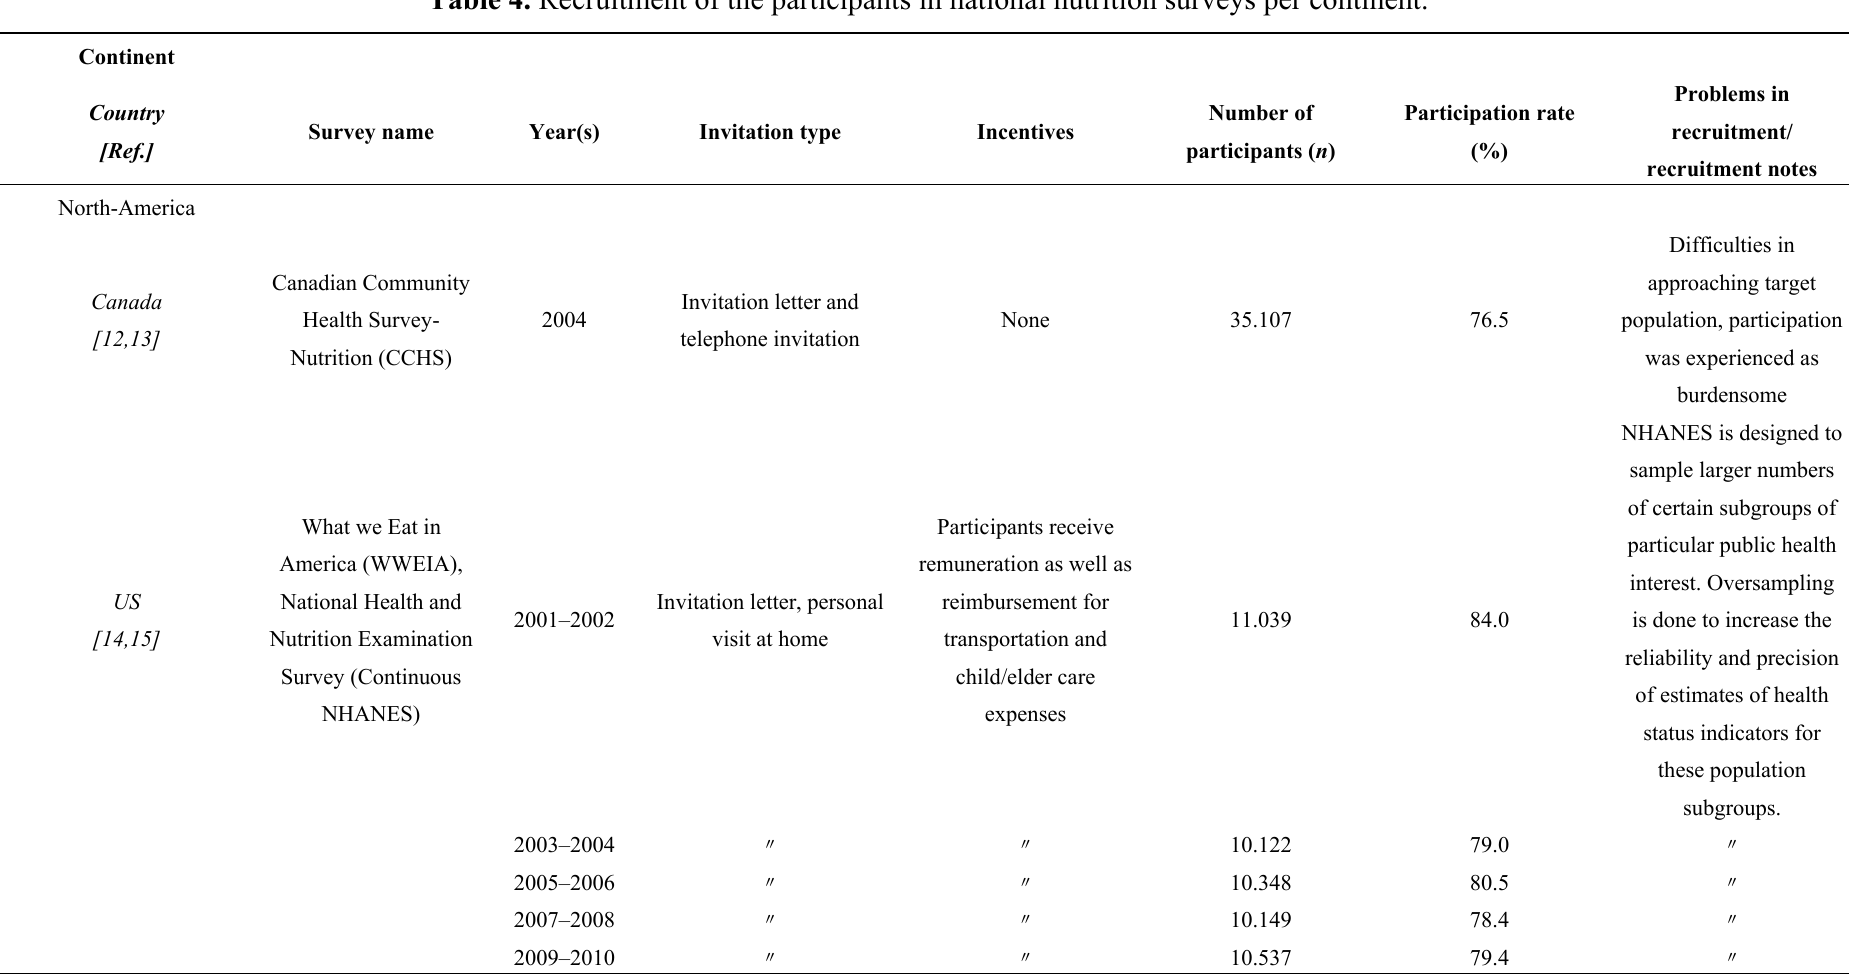
Table 4. Recruitment of the participants in national nutrition surveys per